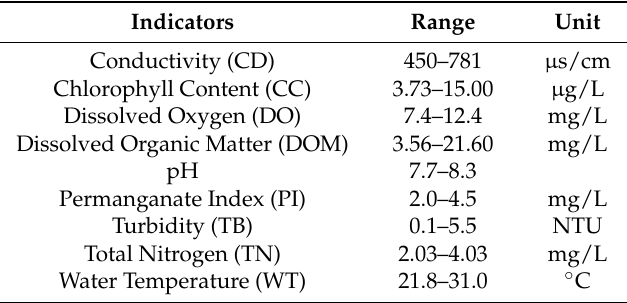
Table 1. Data ranges of nine daily water quality